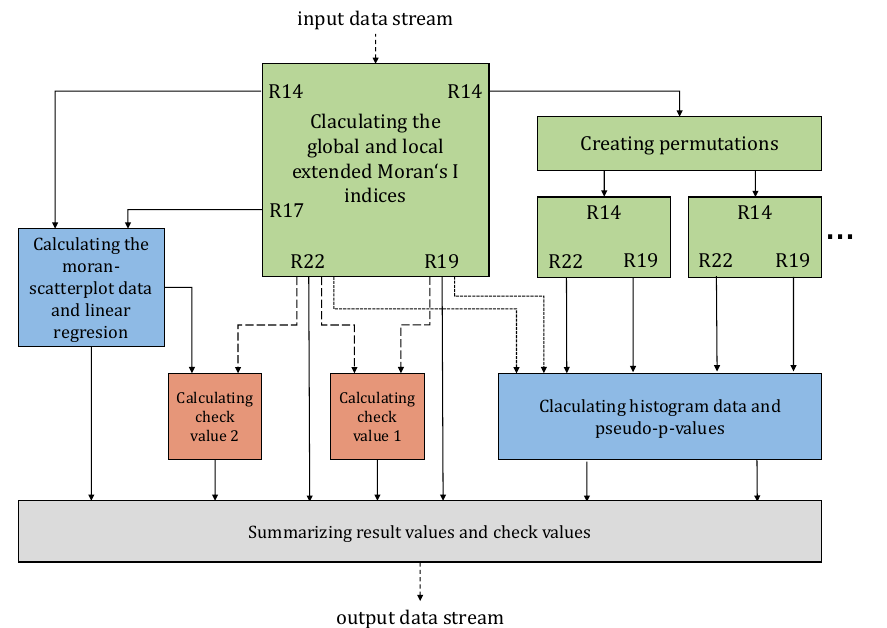
Figure 3. Schematic illustration of the process for generating the result values and check values, with the result names from Table